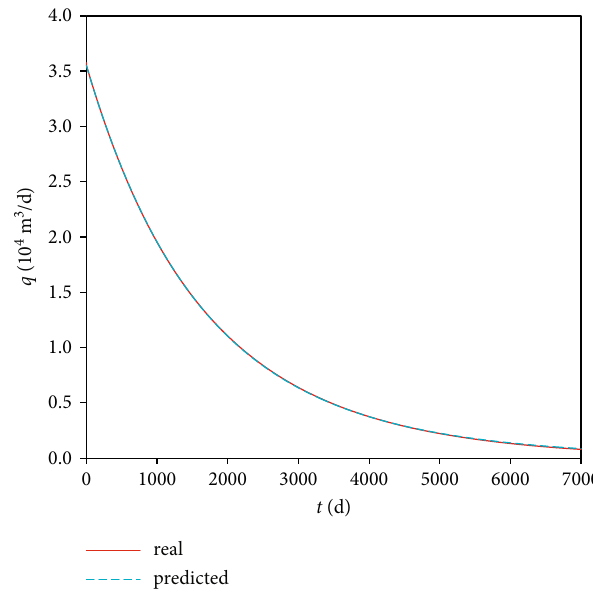
Figure 21: The relation curve of p cases.